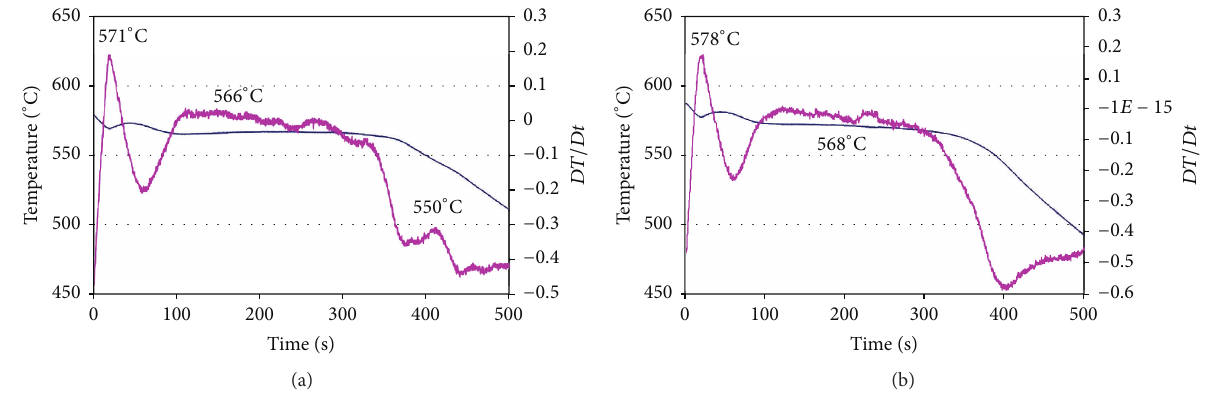
Figure 6: Solidification curve and first derivative for (a) E0S alloy and (b) E9S alloy.